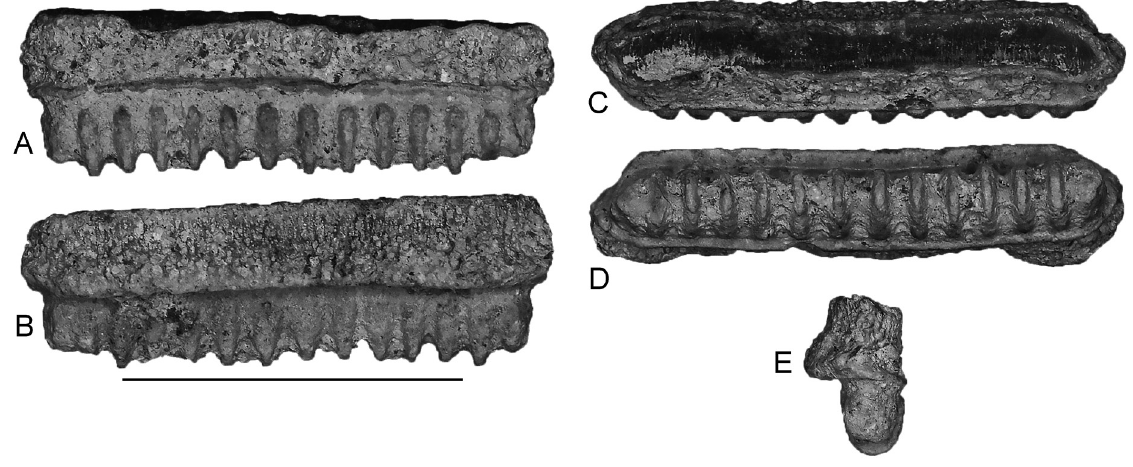
Fig. 54. Eoplinthicus yazooensis Cappetta & Stringer, 2002, median tooth. A–E . ALMNH